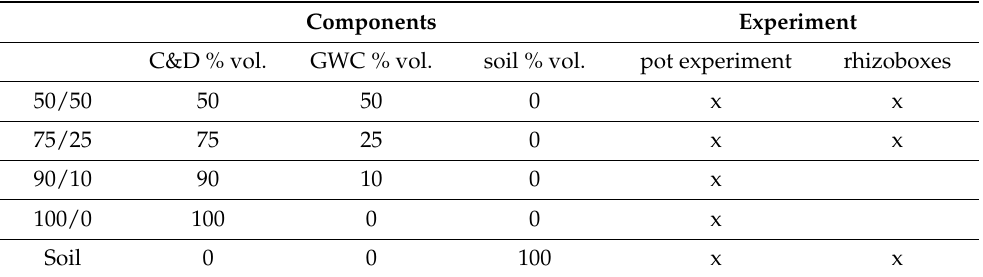
Table 1. Composition of the technosols and their application in experimental work, as indicated by ‘x’. Term C&D denotes construction and demolition fines and GWC denotes green waste